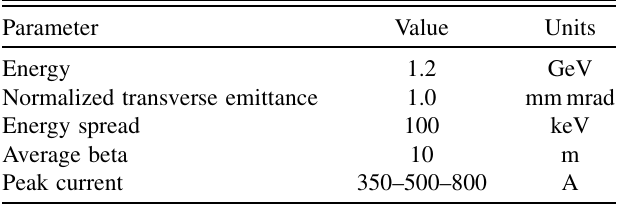
TABLE I. Electron beam parameters used for this work and describing the parameters for FERMI electron beam. Parameter Value Units Energy Normalized transverse